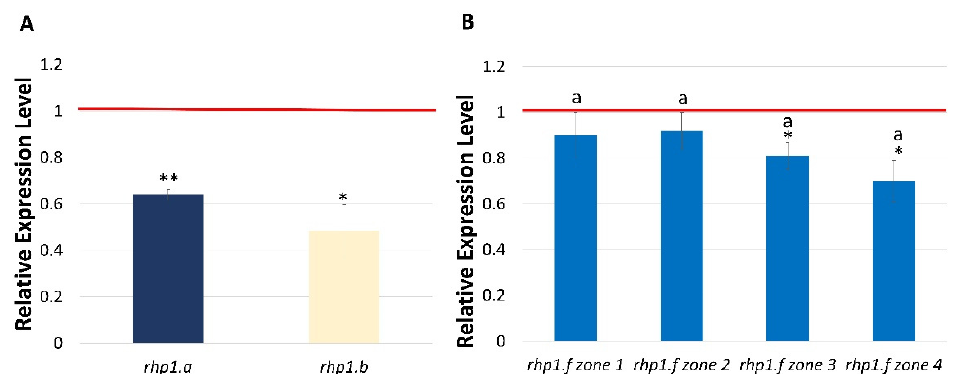
Figure 6. Expression profile of HvCSLC1 gene in allelic rhp1 mutants: ( A ) in roots of rhp1.a and rhp1.b and ( B ) in four root zones of rhp1.f , normalized to the expression level in the corresponding organs/root zones of WT, which was considered as the value 1 (red line). Root zones: 1—meristematic, 2—elongation, 3—differentiation and 4—developed root hair zone. Different lowercase letters indicate the significant differences between analyzed root zones of rhp1.f mutant according to the one way ANOVA, Tukey’s HSD test ( p < 0.05). Asterisks indicate the significant differences between mutant and parent variety according to the Student’ t -test (** p < 0.01; * p < 0.05). Graphs show mean values of n = 3 with SEM.